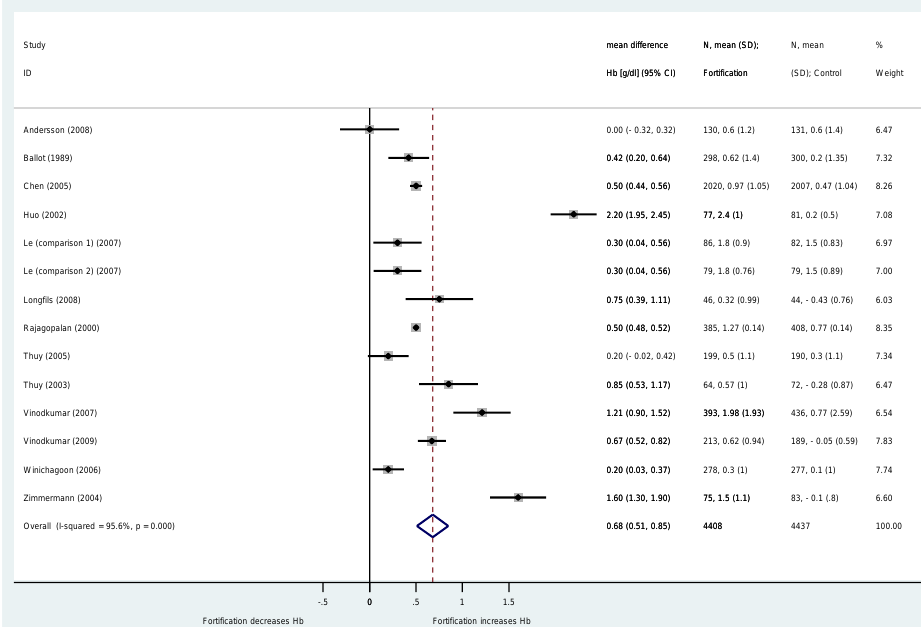
Figure 2. Effect of fortified condiments and noodles on hemoglobin (Hb) concentrations compared to non-fortified condiments or noodles. Included are 13 studies with 14 comparisons. Results are provided as weighted mean difference in hemoglobin (WMD: g/dL with 95%-CI) between intervention and control group.